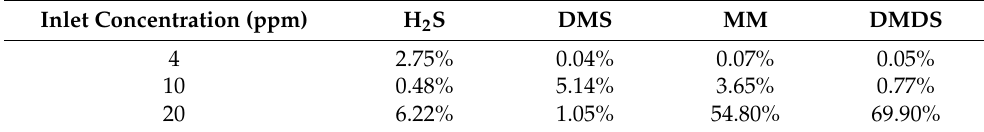
Table 5. p -values between models at different input concentrations per compound. Inlet Concentration (ppm)